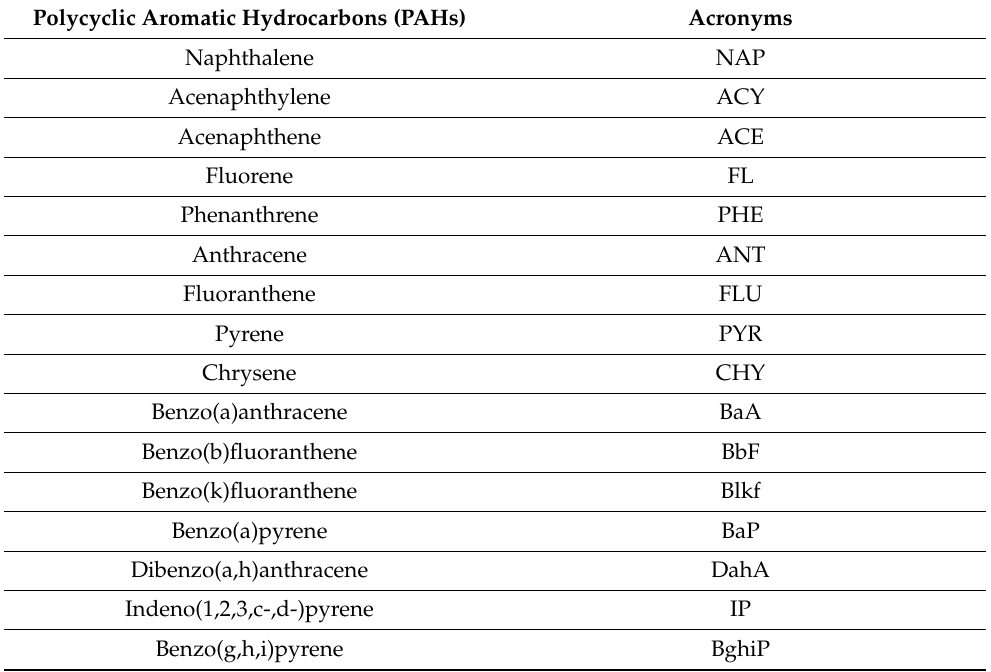
Table 1. Acronyms of the PAHs investigated in this study.